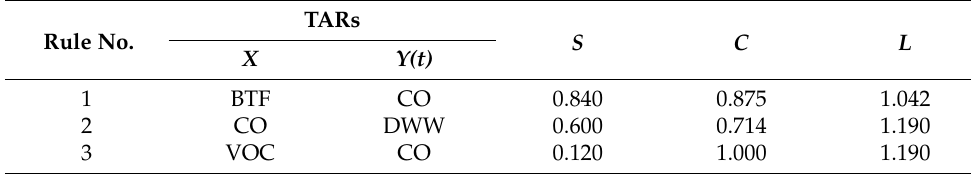
Table 8. TAR results for fishing vessels.